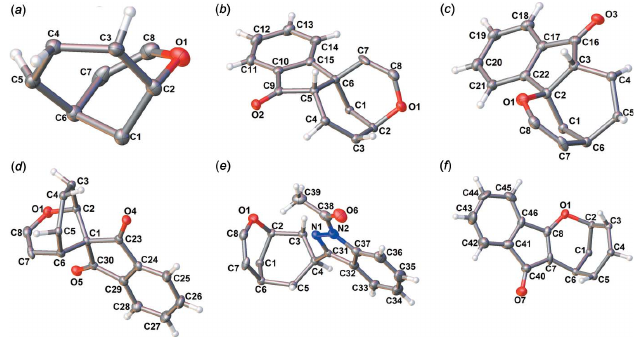
Figure 2 View of one of the independent molecules in the title compound showing the atom-labelling scheme. Displacement ellipsoids are drawn at the 50% probability level.